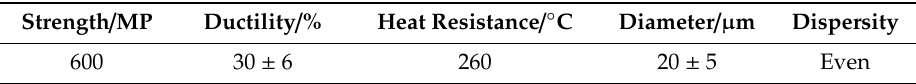
Table 3. Technical indicators of polyester